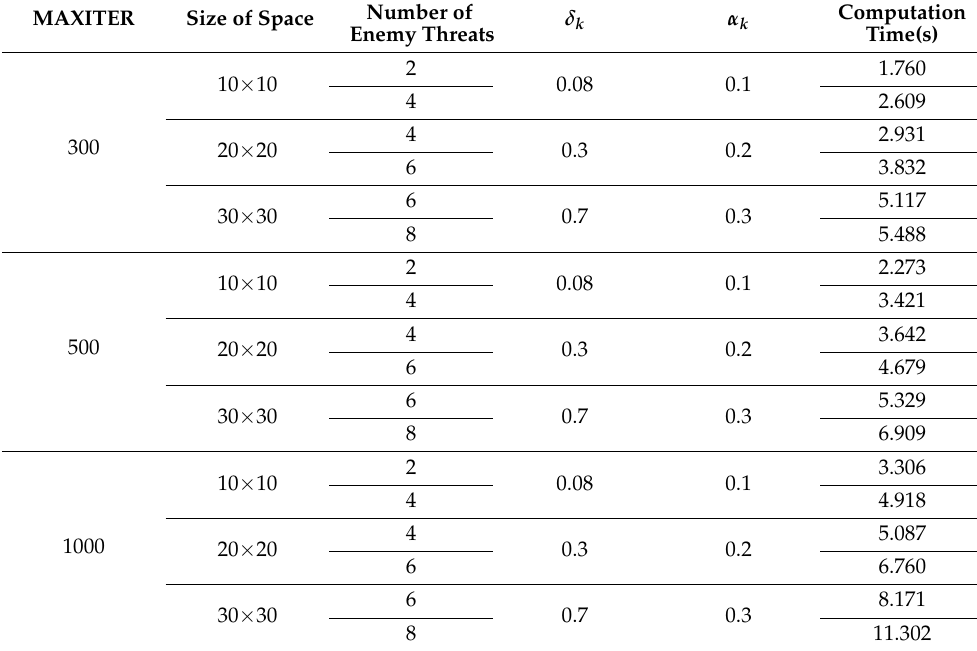
Figure 10. Cycling problems and remedies: ( a ) Cycling caused by inappropriate δ k . ( b ) Cycling caused by enemy threats. ( c ) Remedy for problem ( a ): changing δ k ; ( d ) remedy for problem ( b ): changing direction p k to an intermediate point. Table 3. Computational time of the PFP model in various